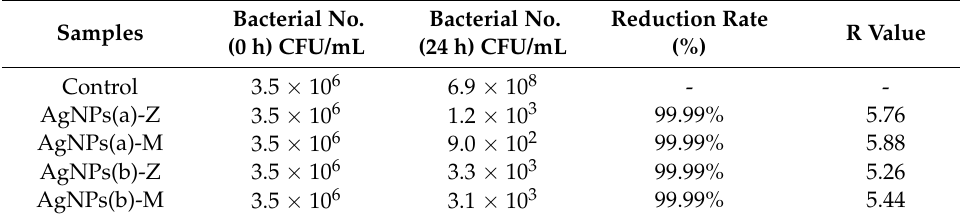
Table 3. Antimicrobial performance for the coatings.